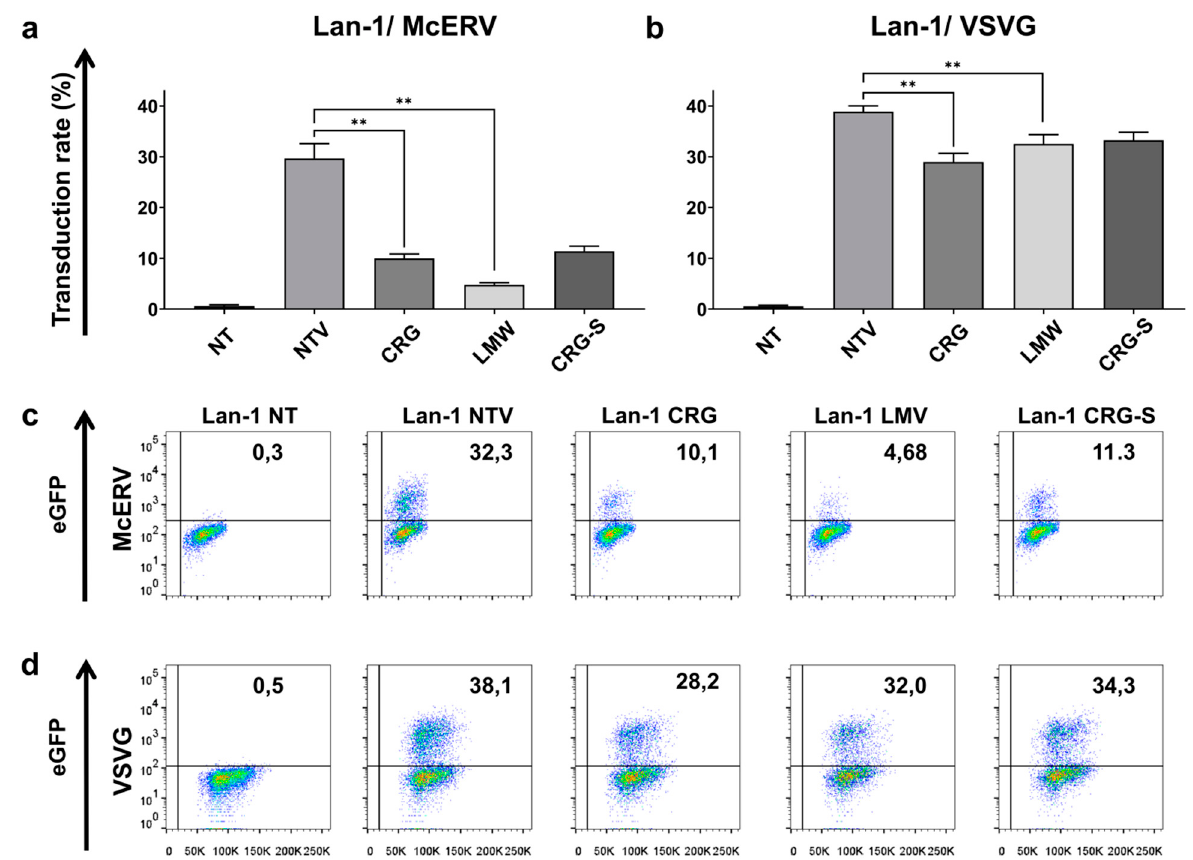
Figure 7. Antiviral action of κ / β -CRG and their oligosaccharide against replication defective viruses pseudotyped with McERV or VSVG envelope proteins. ( a ) Percentage of GFP positive Lan-1 cells measured by flow cytometry 72 h after adding supernatans containing McERV-pseudotyped RDLVs at presence of carrageenans ( κ / β -CRG, LMW, Car-S). NT: non-transduced cells and not treated with CRGs, NTV: transduced cells not treated with CRGs were used as controls. ( b ) Percentage of GFP positive cells measured by flow cytometry 72 h after adding supernatants containing VSVG-pseudotyped RDLVs at presence of CRGs. ( c ) Flow cytometry analysis of Lan-1 cells transduced with RDLV-McERV and treated with CRGs. ( d ) Flow cytometry analysis of Lan-1 cells transduced with RDLV-VSVG and treated with CRGs. ** p < 0.005 as calculated by Mann–Whitney non-parametric test.